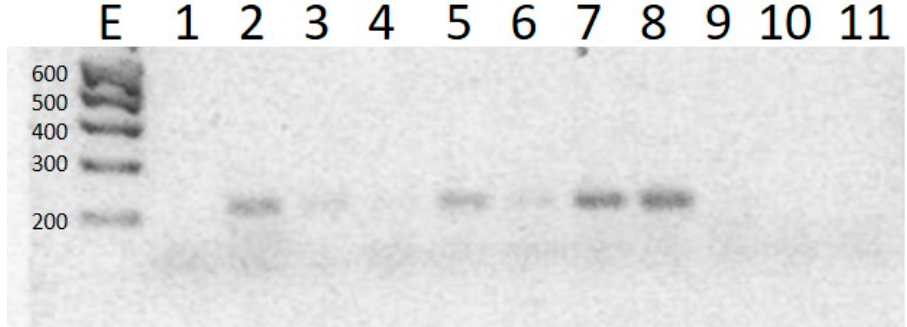
Figure 3. Picture of a 2% Agarose gel, dyed with redGel ® stain, representative of PCR products of E.coli , using primers for the tet(A) gene (210 bp) in droppings from broiler chickens that were treated with therapeutic doses of CTC. Lane E: Molecular weight marker; Lane 1: negative control; Lanes 2 to 8: amplified product of sample treated with chlortetracycline; Lanes 9 to 11: tet(A) gene was not expressed and they represent products from blank samples sourced from birds in the control group.